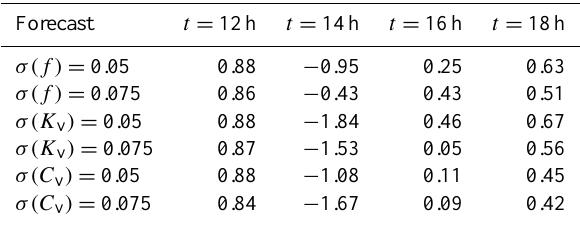
Table 2. Results of the NSE ( ˜ y 0 ) for different dispersion in the mu- tation